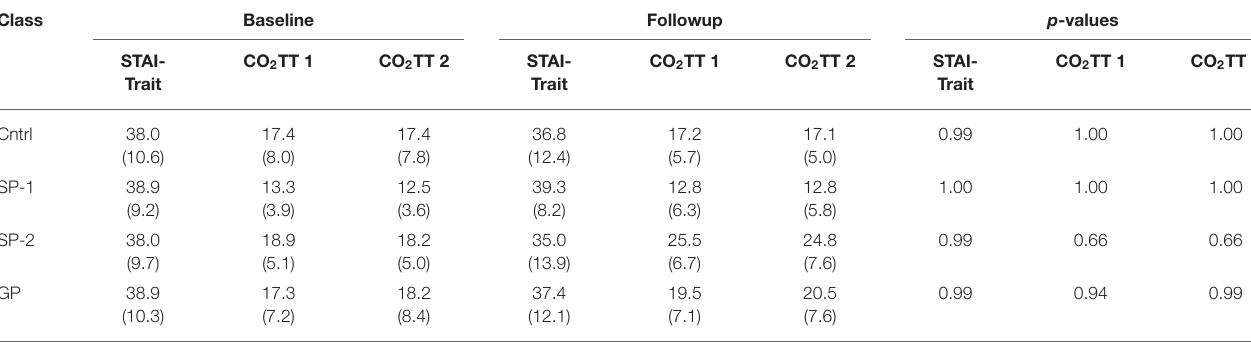
TABLE 3 | Mean (SD) STAI-Trait and CO 2 TT scores at baseline and follow-up, by class*. Class Baseline Followup